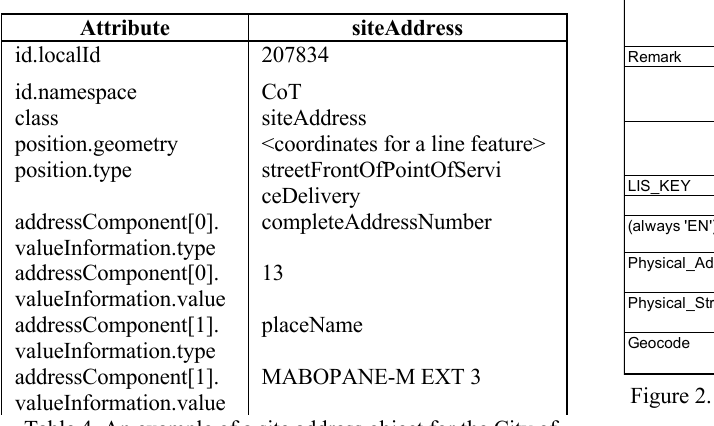
Table 4. An example of a site address object for the City of Tshwane (Based on SANS 1883-2:2018)